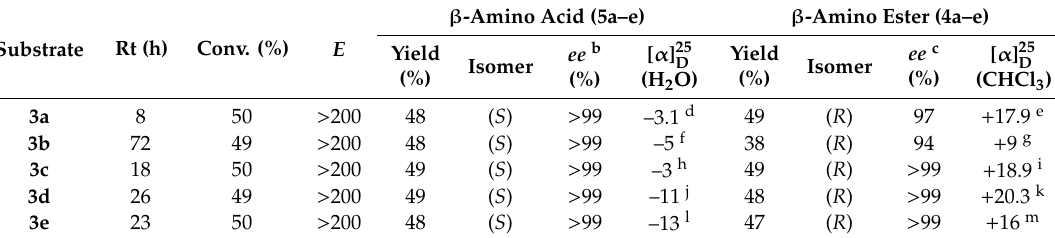
Table 5. Lipase PSIM-catalyzed hydrolysis of ( ± )-3 a – e a .